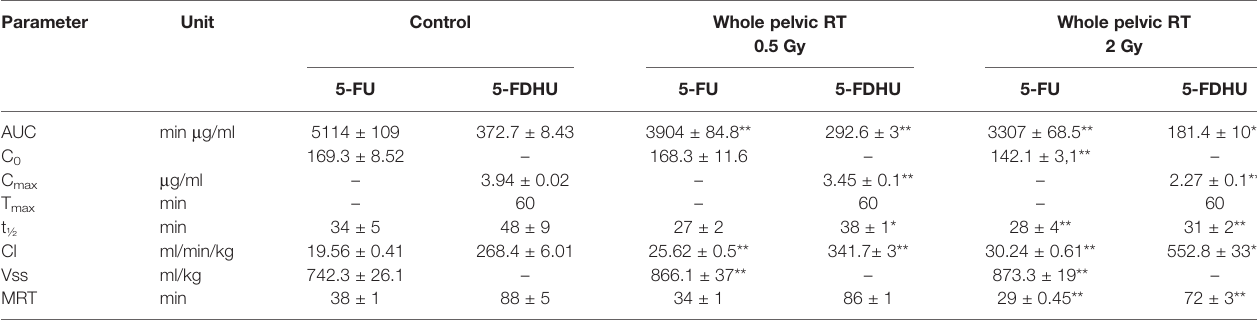
TABLE 5 | Pharmacokinetic parameters of 5-FU (100 mg/kg, i.v.) and 5-FDHU from rat plasma.